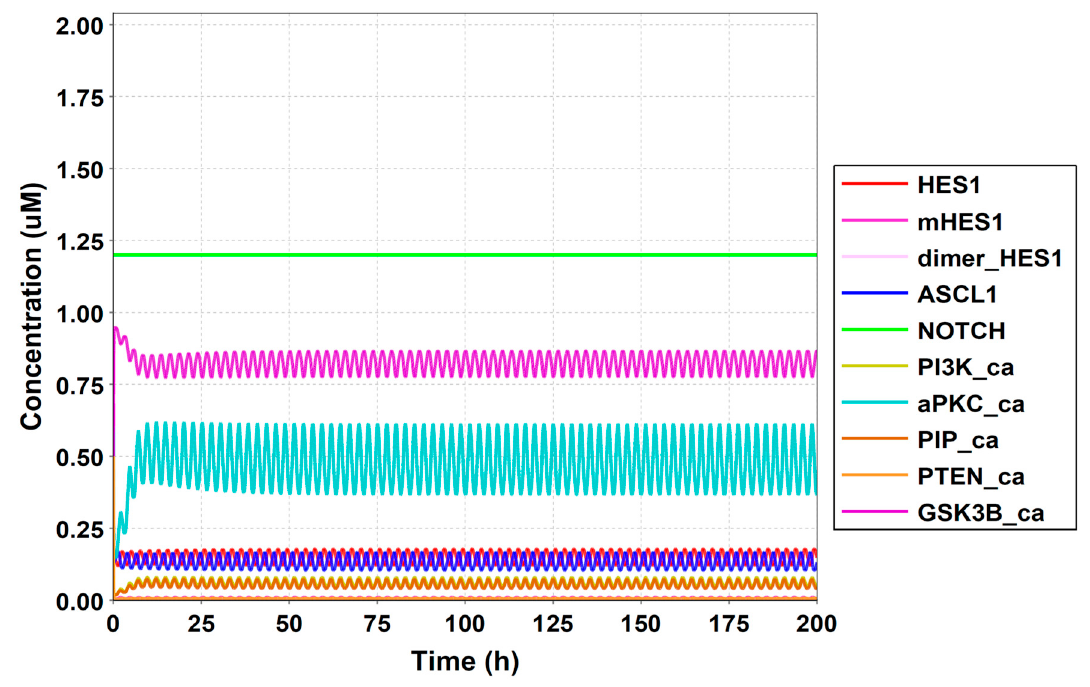
Figure A7. Simulation result of all species.